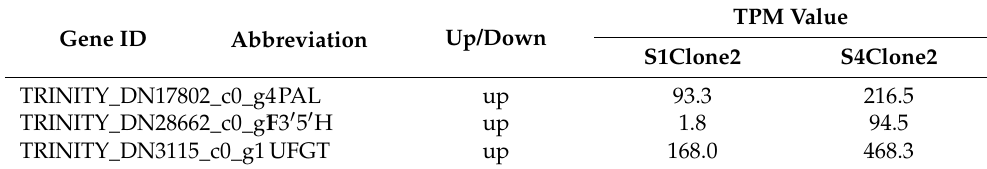
Table 2. DEGs related to anthocyanin biosynthesis in clone